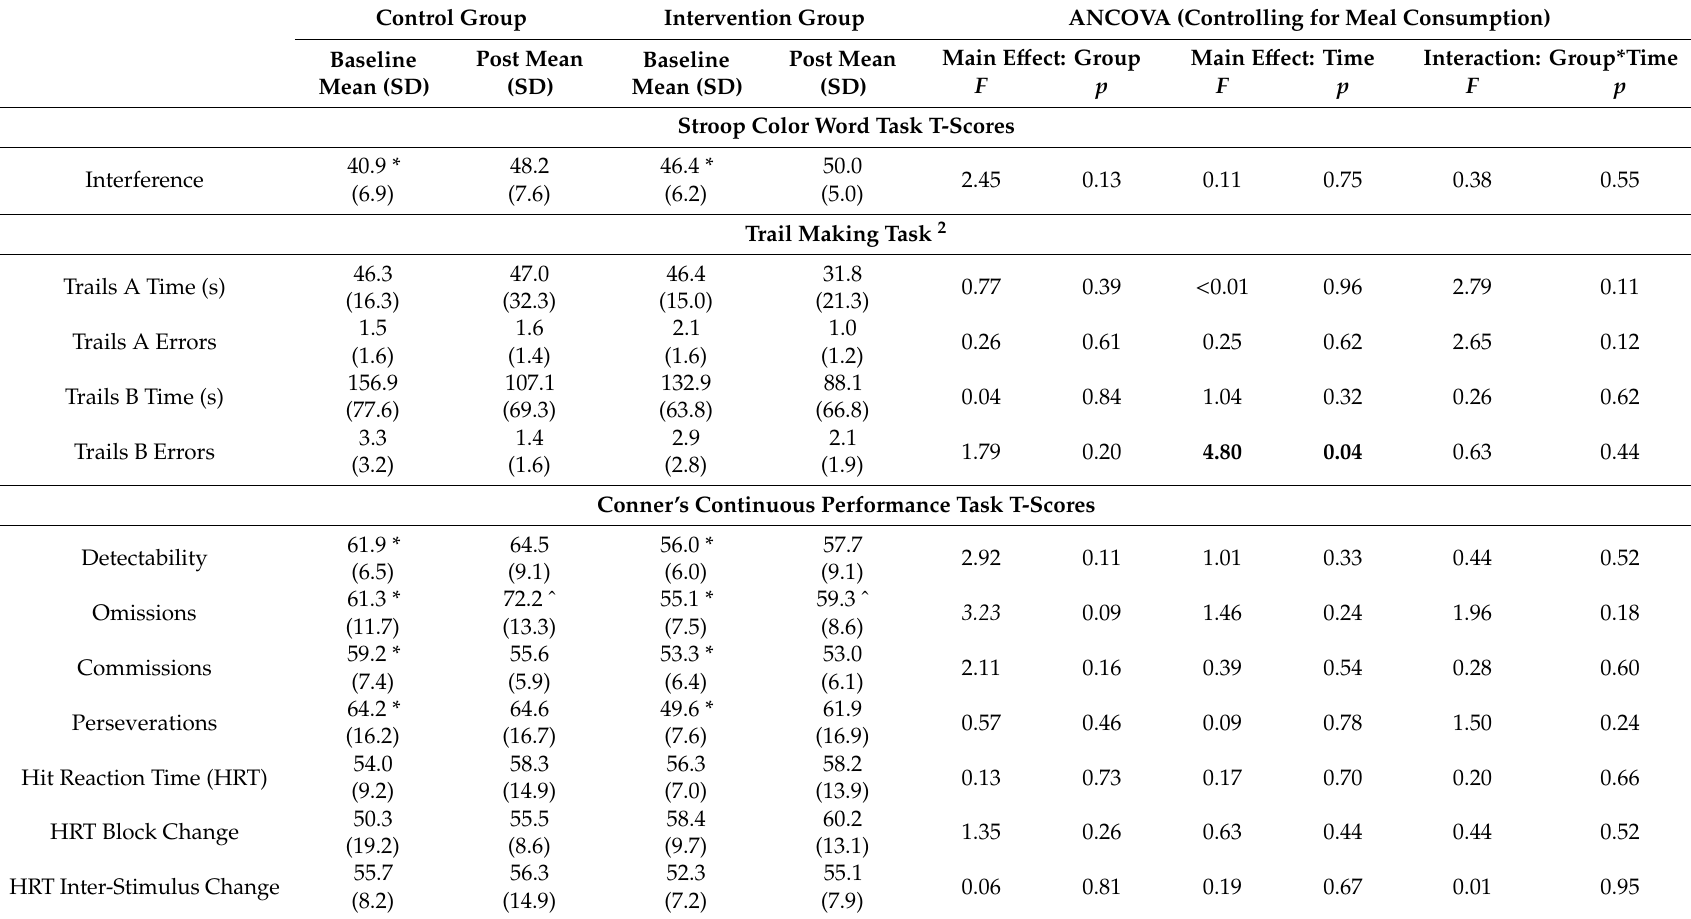
Table 3. Cognitive Scores among Students Participating in a feeding trial 1 at baseline and post-implementation: Analyses of Co-Variance (ANCOVA) Results Controlling for Amount of Meals Consumed and with Performance Outliers